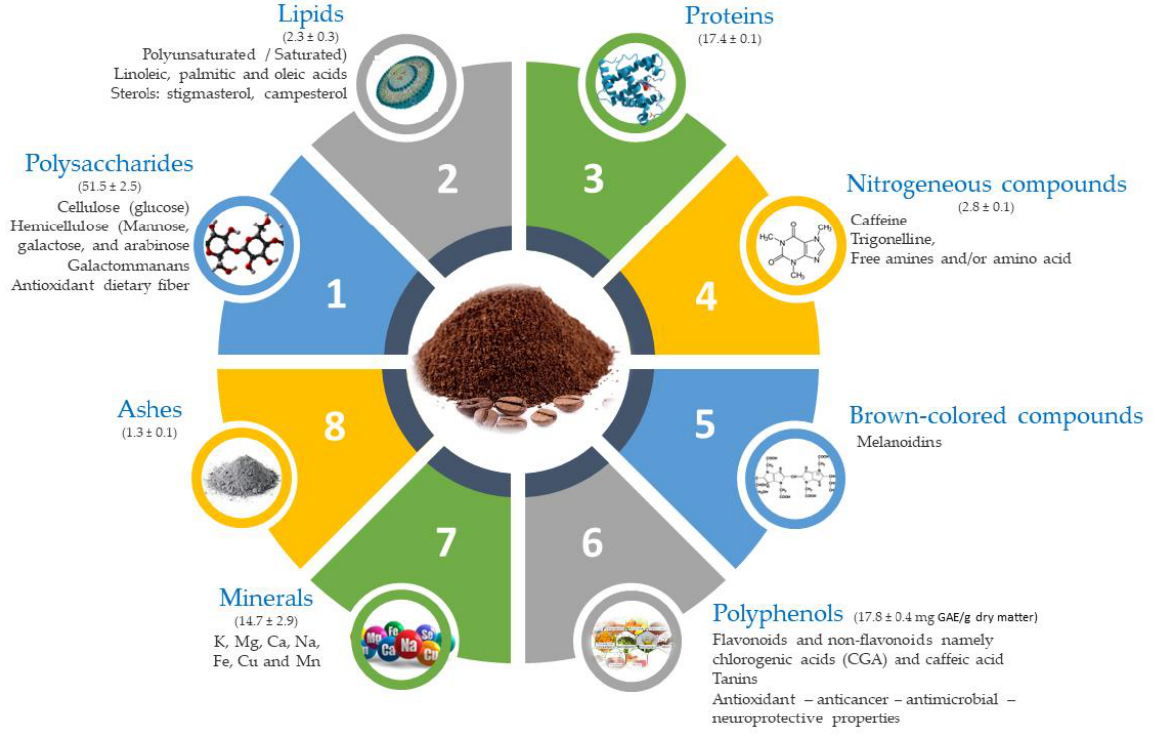
Figure 1. Main composition of spent coffee grounds (composition expressed in g/100 g of dry material).